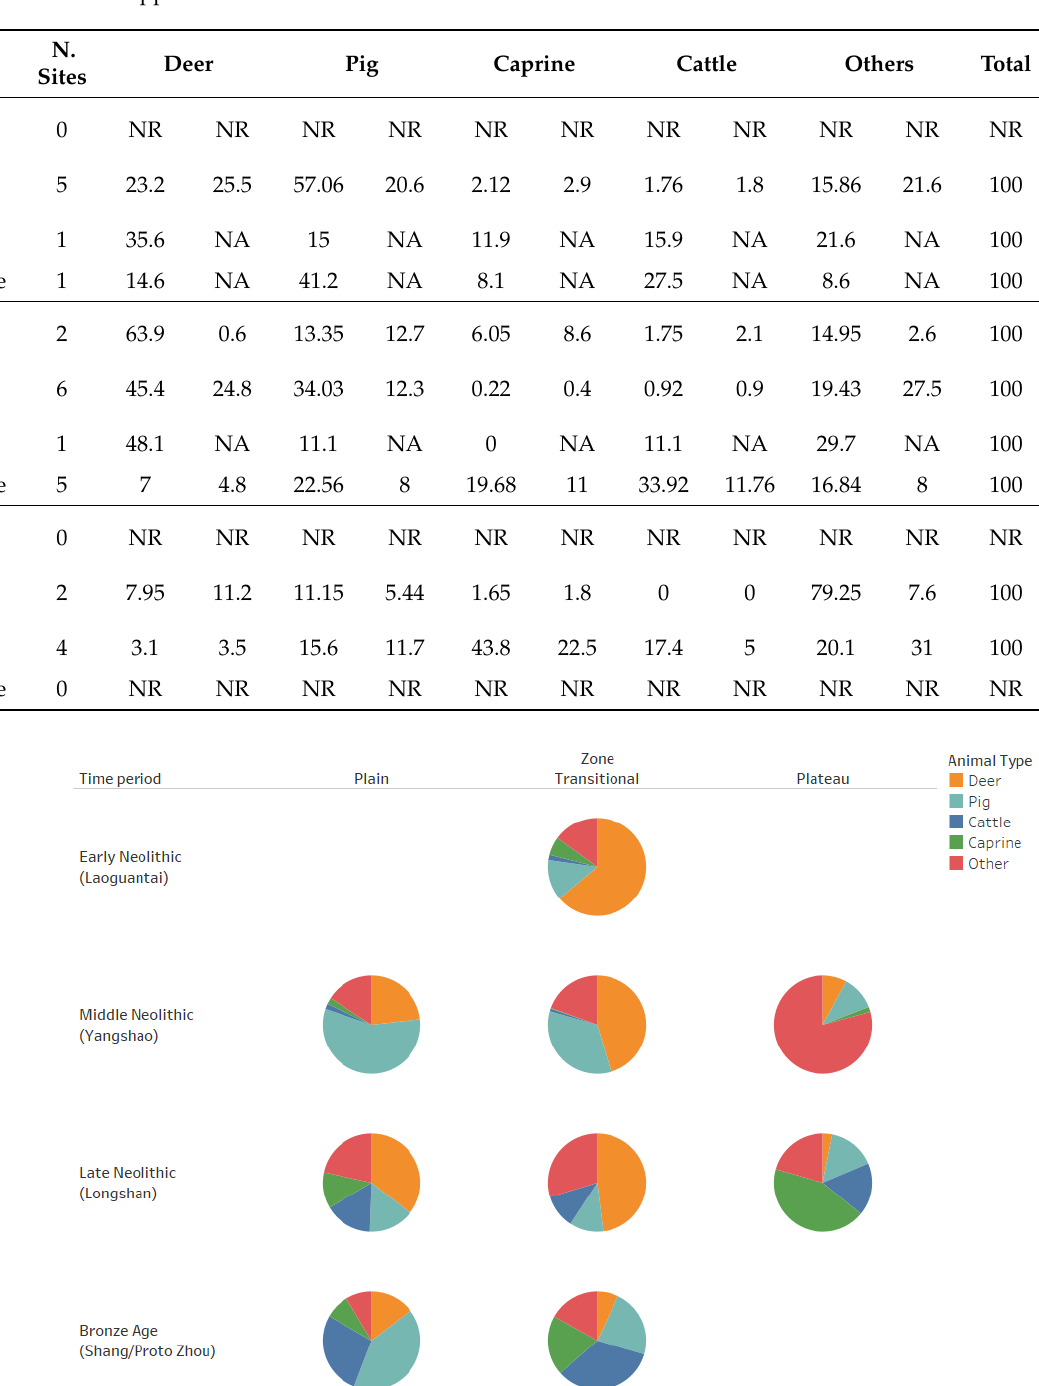
Table 3. Average taxonomic abundance for Deer, Pig, Caprine, Cattle, and Others by %NISP per time period and per zone. Those instances for which there are no data available are marked with the notation NR. Differences between sites are highlighted using Standard Deviation (SD). Given the small sample size, high standard deviation values are expected. Data sources are listed in